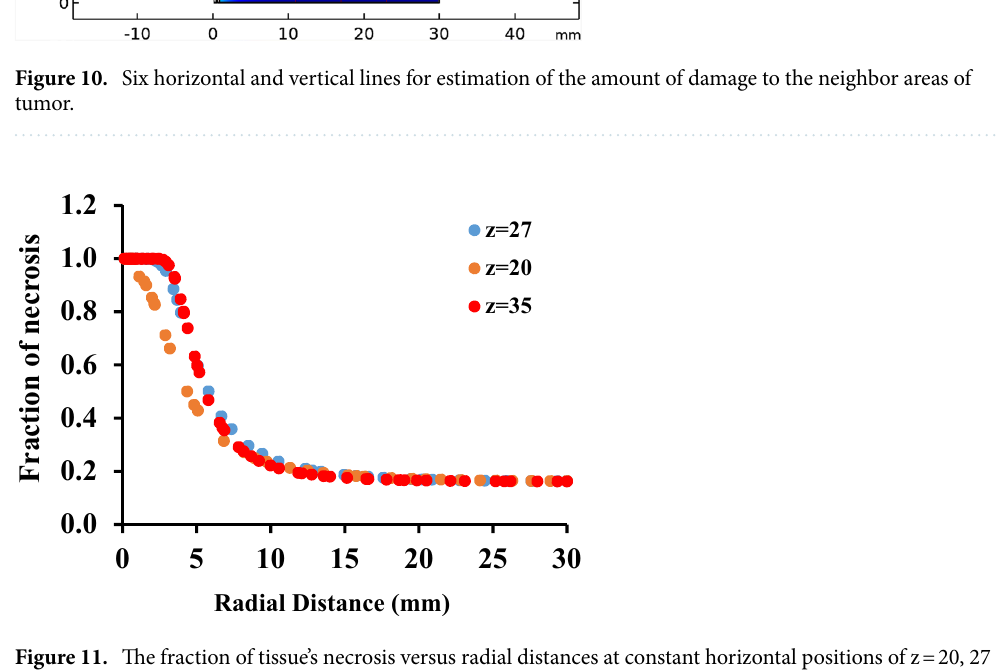
Figure 11. The fraction of tissue’s necrosis versus radial distances at constant horizontal positions of z = 20, 27 and 35